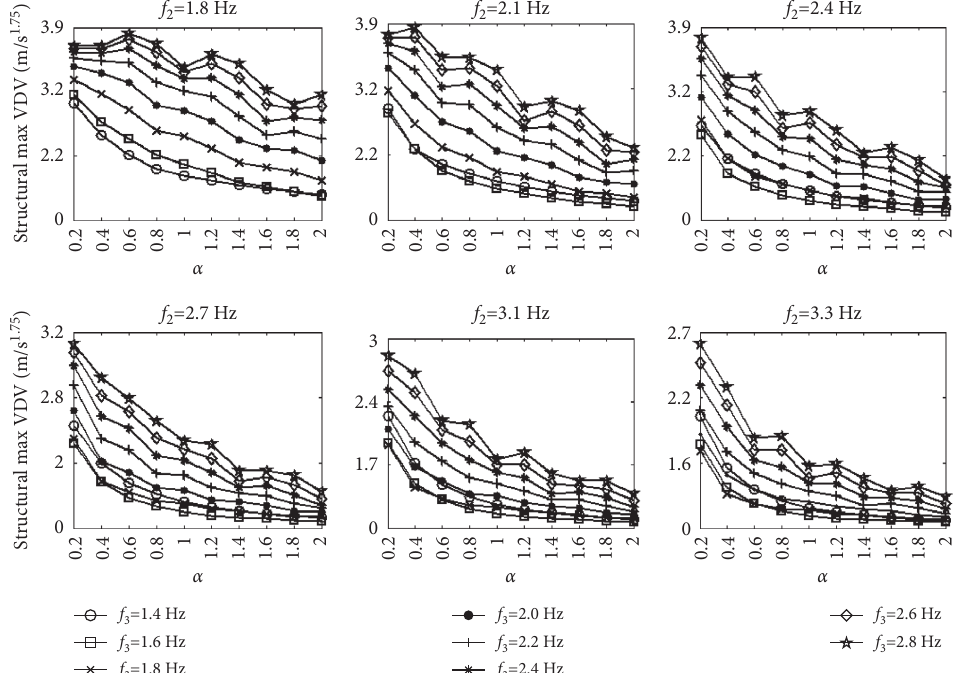
Figure 21: The influence of other f